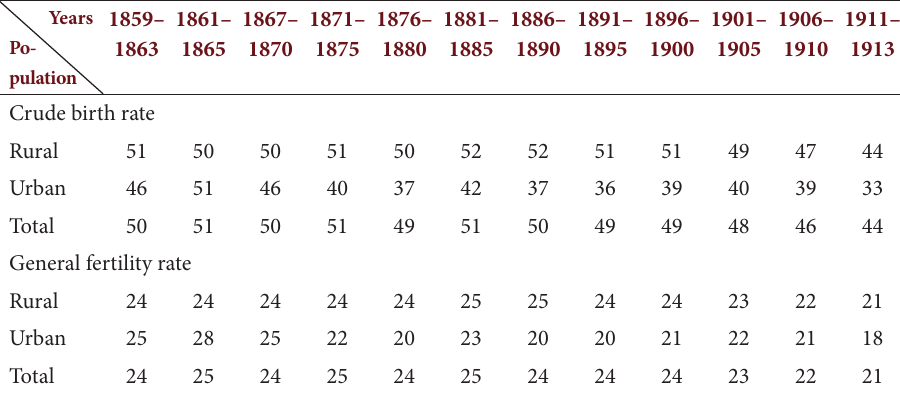
Table 2. Crude birth and general fertility rates among rural and urban population in European Russia in 1859-1913.,